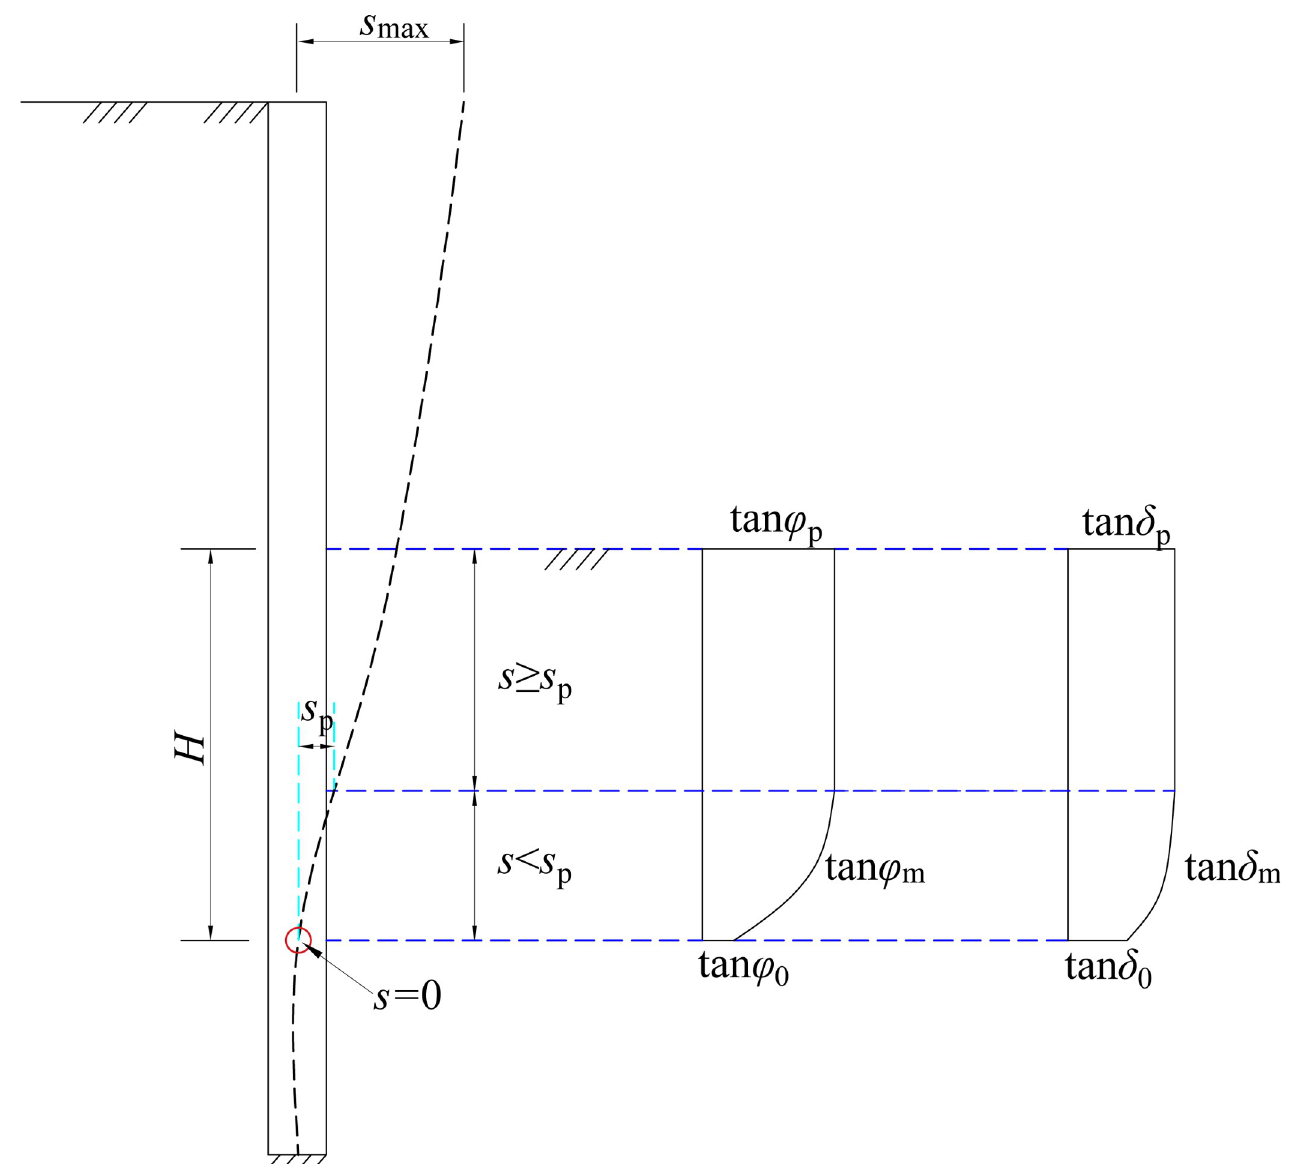
Fig 14. φ m and δ m varying along the height of retaining